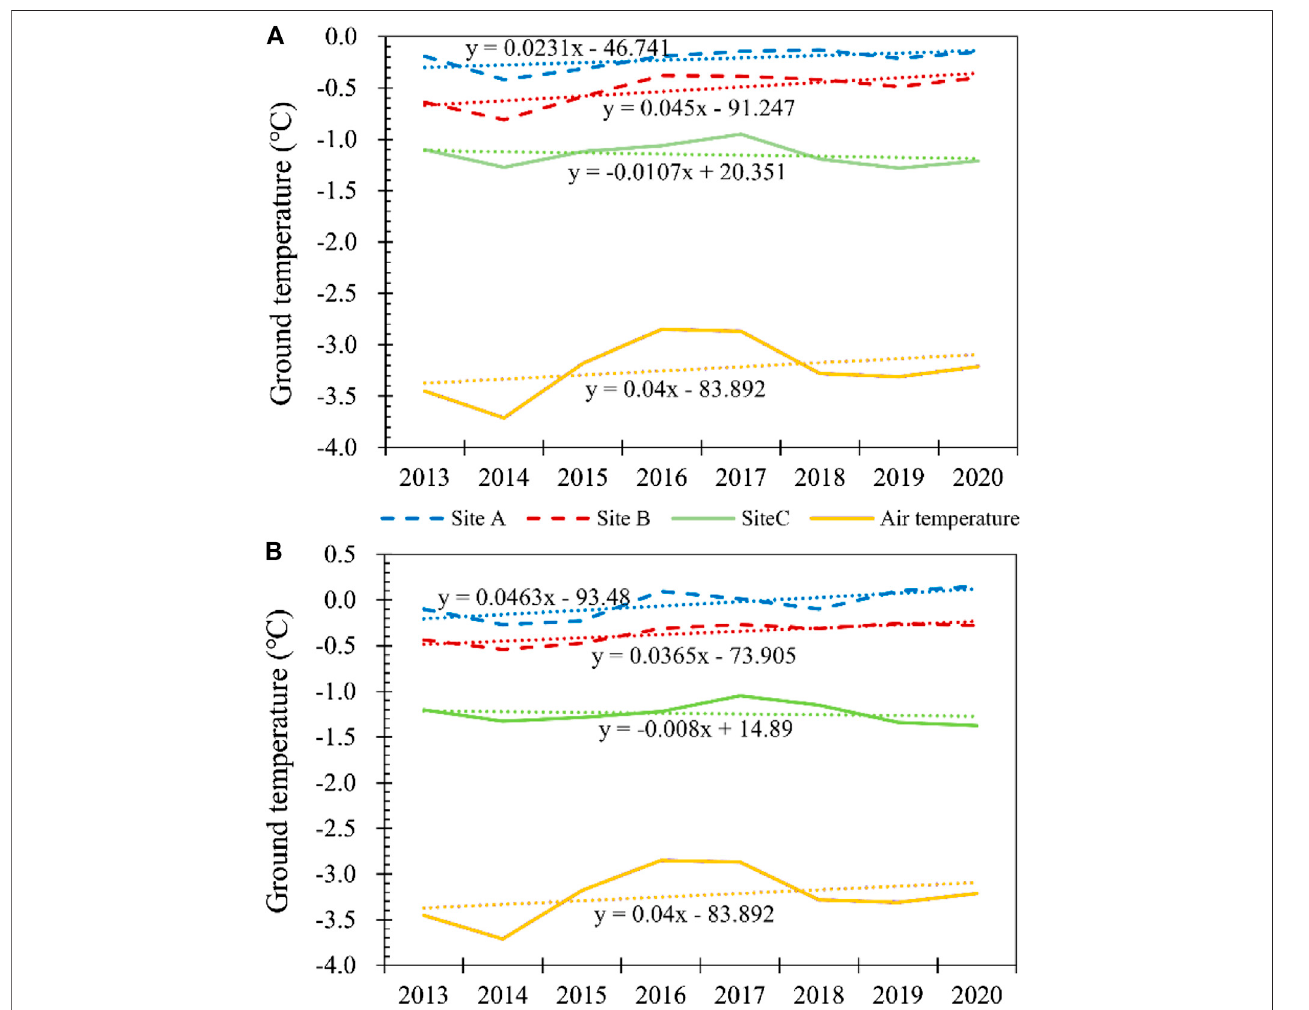
FIGURE 3 | Annual mean ground temperatures in the active layer at the three sites from 2013 to 2020. (A) 1.0 m depth, and (B) 2.0 m depth. The annual mean air temperatures during the same period are also shown.